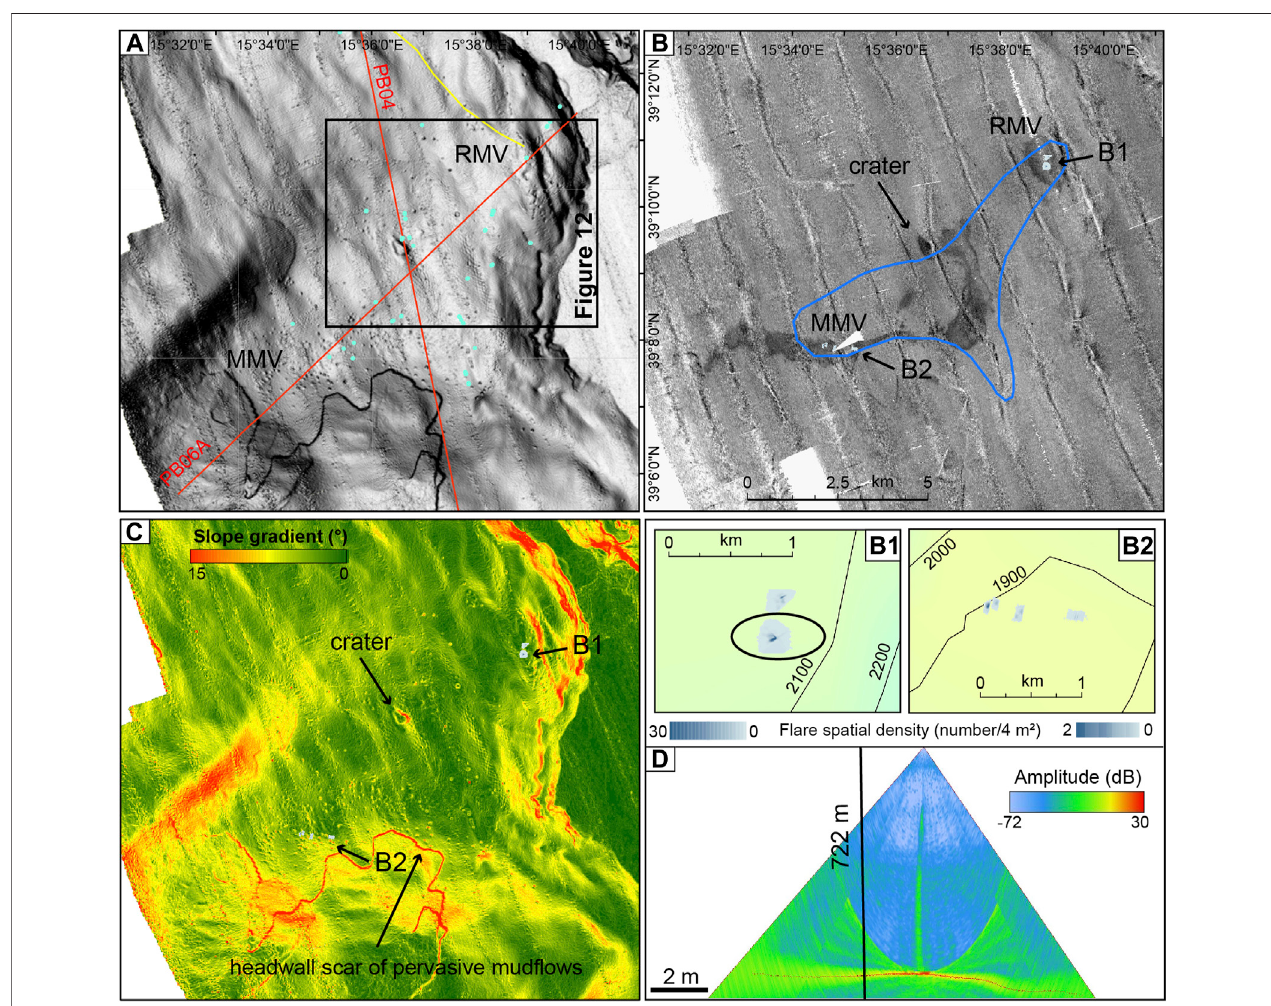
FIGURE 11 | (A) High-resolution MBES bathymetry of the southern sector of the study area with track lines of the MCS data (red), vertical bright spots identi fi ed in CHIRPpro fi les(smallbaby-bluecircles). (B) MBESbackscatterofthesea fl oor,theareaofshallowhigh-amplitudere fl ectorsinCHIRPpro fi lesisoutlinedinblue. (B1,B2) are enlargements of fl are density above MMV and RMV superimposed to the depth of the Messinian re fl ector. (C) Slope gradient calculated from the MBES bathymetry showing the overall mounded structure comprising MMV and RMV. (D) Fan view of the gas fl are detected in the water column above RMV by the MBES EM302 corresponding with the ellipsis in (B1) . The area is outlined in Figure 2B